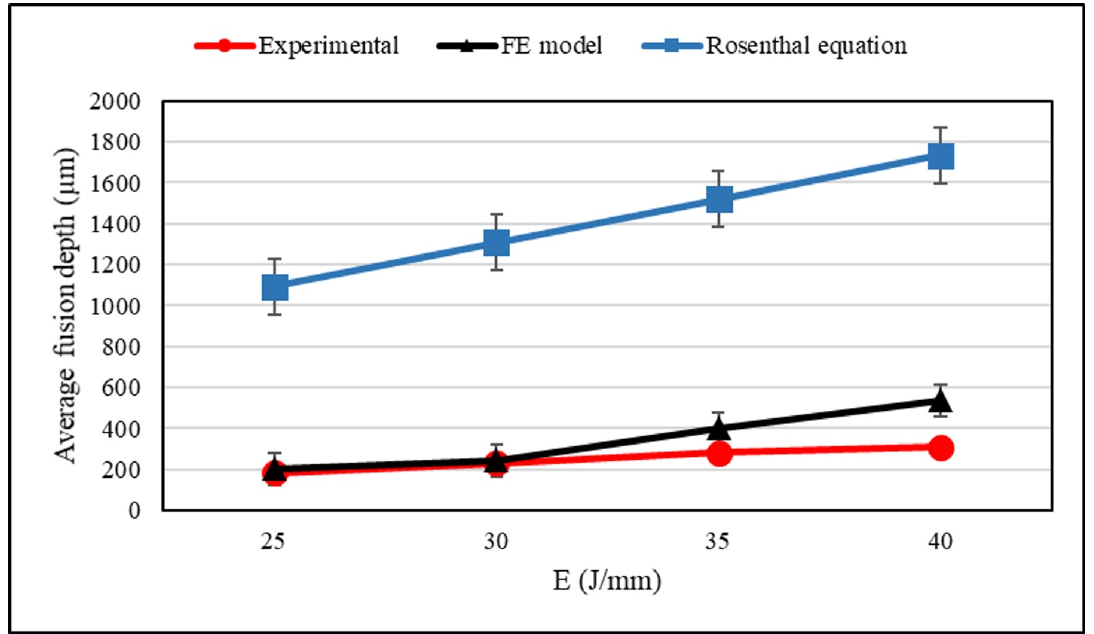
Figure 6. Comparison of the fusion depth obtained from experiments, the numerical modeling, and the analytical Rosenthal equation.